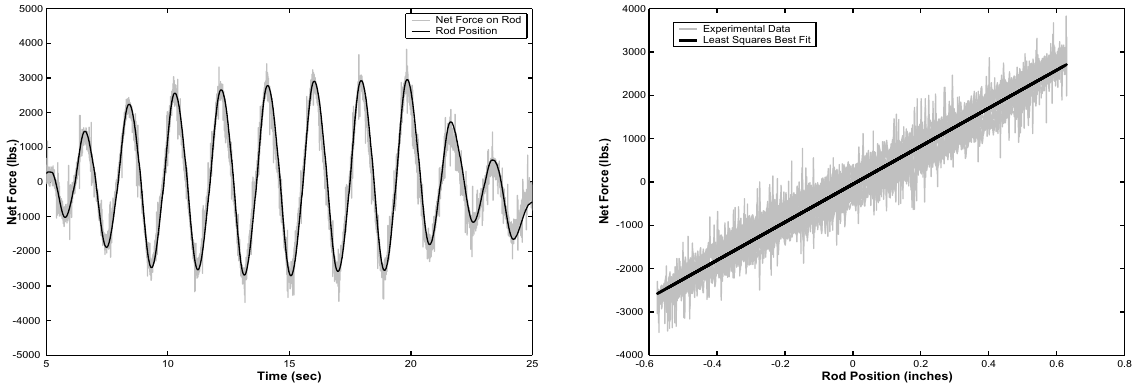
Fig. 3. Rod position (scaled) and force versus time (left) and rod force versus position (right). Both with the valve closed and an initial pressure of P = 285